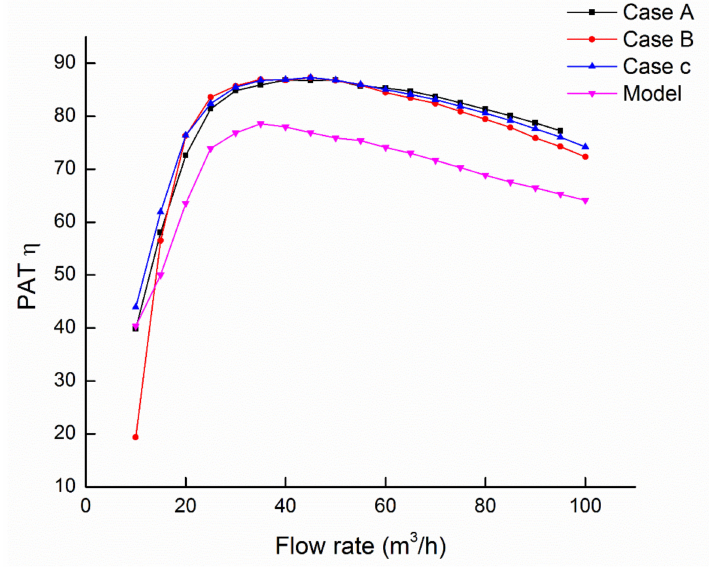
Figure 19. Predicted PAT e ffi ciency comparison at di ff erent flow rates.